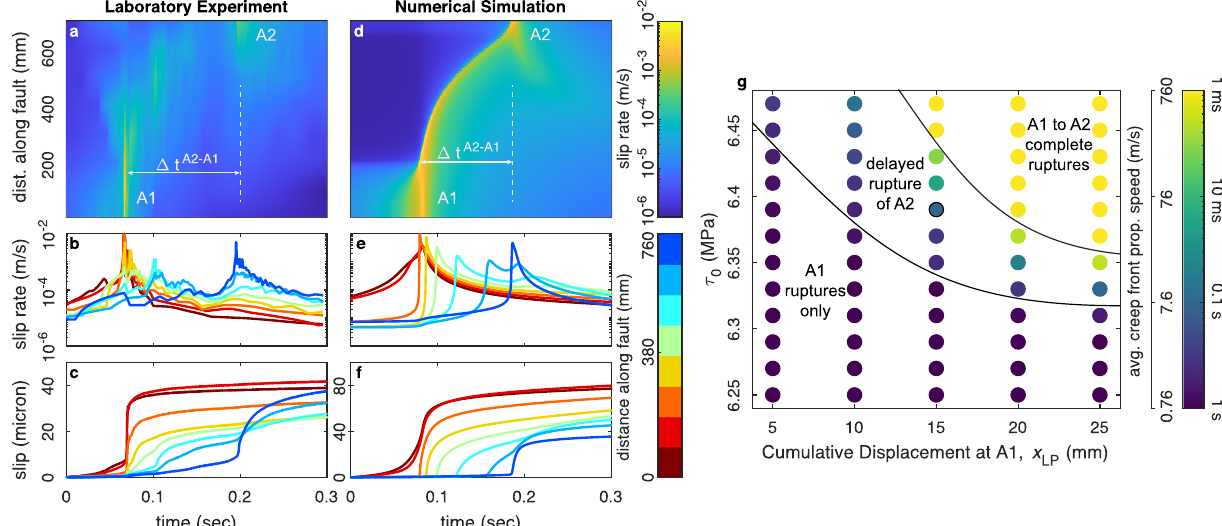
Fig. 3 | Creep front dynamics in the experiment and numerical simulations. a – c ExampleofA1-to-A2delayedtriggeringobservedatx LP =23mmusinglocalslip measurements. d – f RSFnumericalsimulationshowsawell-de fi nedcreepfrontthat both slows down and attenuates as it propagates. g Each dot is a separate RSF